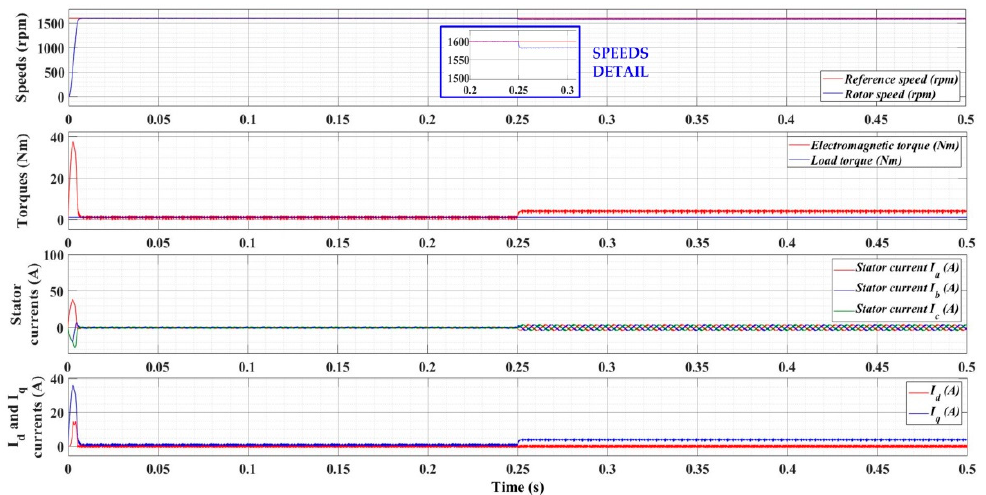
Figure 4. Time evolution for the numerical simulation of the PMSM control system based on the PI-PSO speed controller: ω ref = 1600 rpm, T L = 1 Nm → 4 Nm, K p = 1.69, and K i = 1.56.